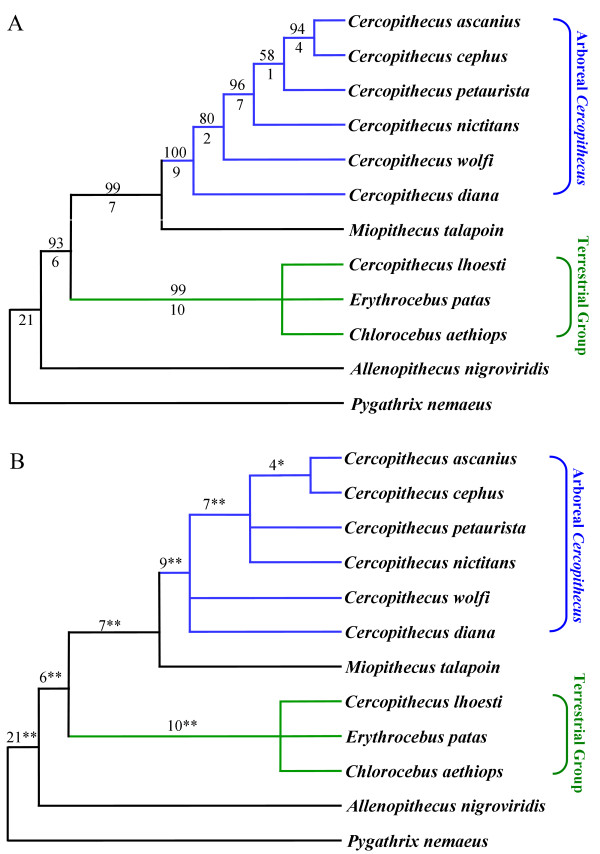
Cladograms of tribe Cercopithecini phylogenetic relationships derived from Alu insertion polymorphisms. The blue section of each phylogeny indicates species of Cercopithecus with an arboreal lifestyle and the green section indicates species with a terrestrial lifestyle. (A) The strict consensus of the two most parsimonious trees from analysis of 179 Alu insertion polymorphisms. The numbers above the branches indicate the percentage of bootstrap replicates (10000 iterations) producing trees that include that node. Numbers below the branches indicate the numbers of unambiguous insertions supporting each node. (B) The collapsed version of tree A. Branches that did not gain statistically significant support in the likelihood test [32] were collapsed into polytomies. The significance level of each node is indicated by either * (p < 0.05) or ** (p < 0.01).